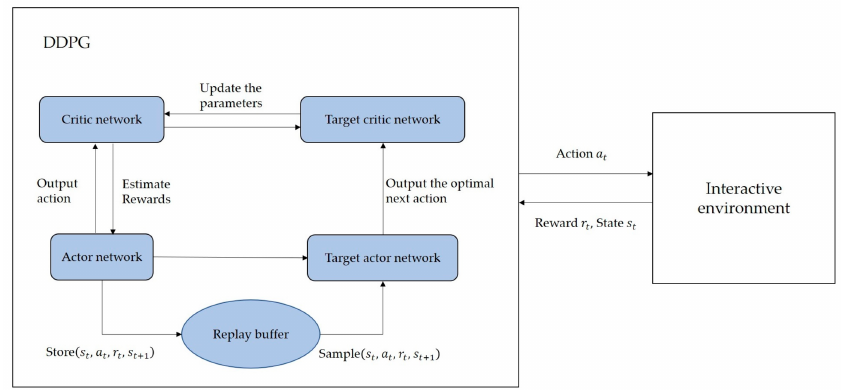
Figure 3. Explanation of the basic principles of